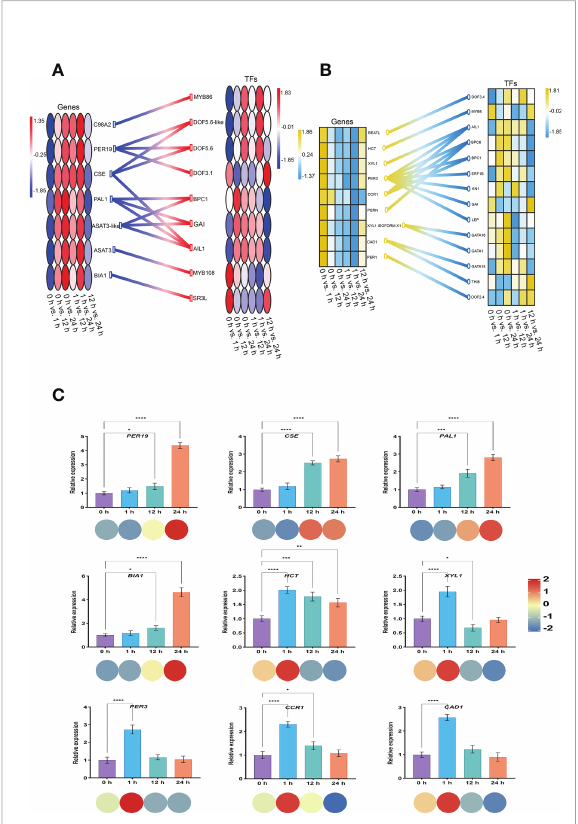
FIGURE 10 Construction of a regulatory network of genes and TFs and qRT- PCR analysis. (A) Heatmap of Spd synthesis genes and regulatory TFs involved in S. lycopersicum roots in response to salt stress. (B) Heatmap of FA synthesis genes and regulatory TFs involved in S. lycopersicum roots in response to salt stress. (C) qRT-PCR analysis of the genes involved in Spd and FA synthesis in S. lycopersicum roots in response to salt stress. The heatmap of genes is located on the left side, and the heatmap of TFs is located on the right side. Different colored circles or boxes represent the RNA-seq expression pro fi les of the genes, and the connecting lines between genes and TFs represent regulatory relationships. The bars represent the qRT-PCR expression of the genes, and the corresponding circles of different colors below represent the RNA-seq expression pro fi les of the genes. Three independent biological replicates were used to calculate the mean. Error bars indicate the SD of the three biological replicates. Values indicate mean ± SD. Dunnett ’ s multiple comparison test was applied to verify the signi fi cance of differences (* P < 0.05, ** P < 0.01, *** P < 0.001, and **** P <